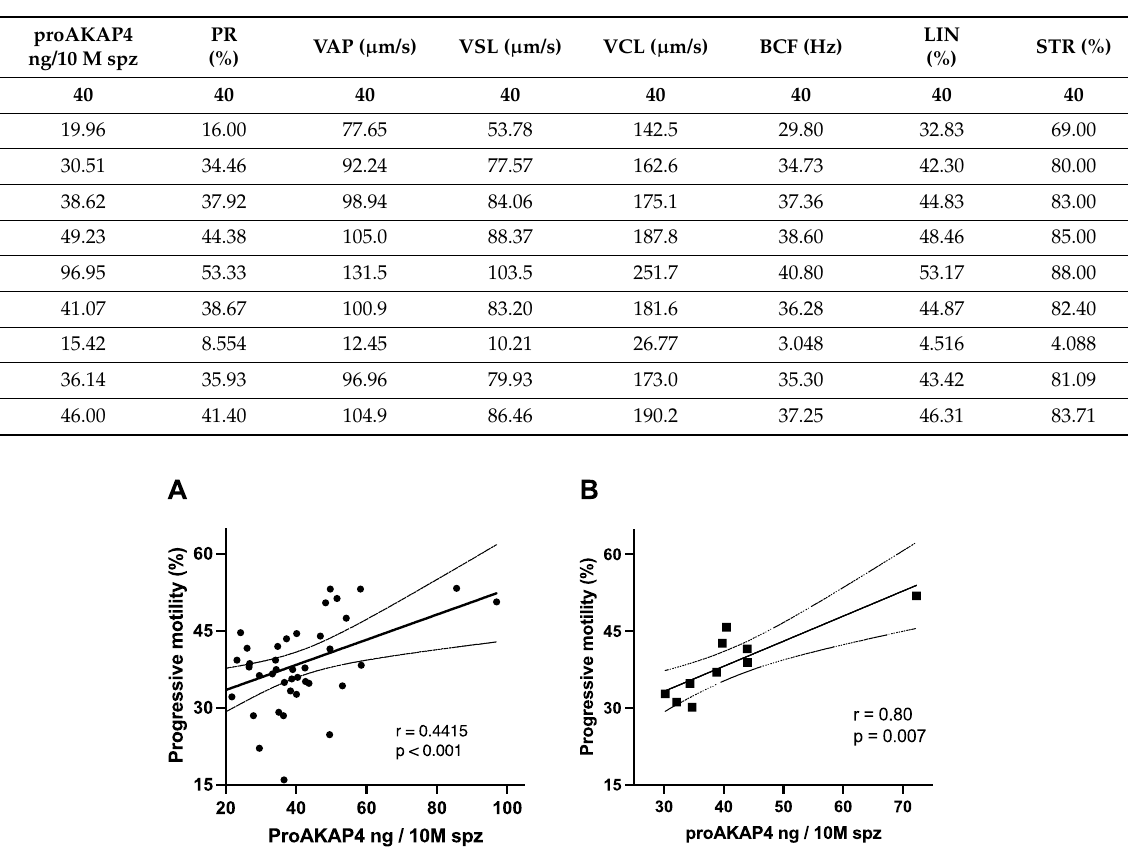
Figure 2. Correlation between proAKAP4 concentration and progressive motility in post-thawed bull semen. ( A ) Correlation of each individual straw ( B ) Correlation of the average of all straws of the same bull. ProAKAP4 concentration in ng per 10 million of spermatozoa (ng/10 M spz) of spermatozoa and percentage of progressive motility.